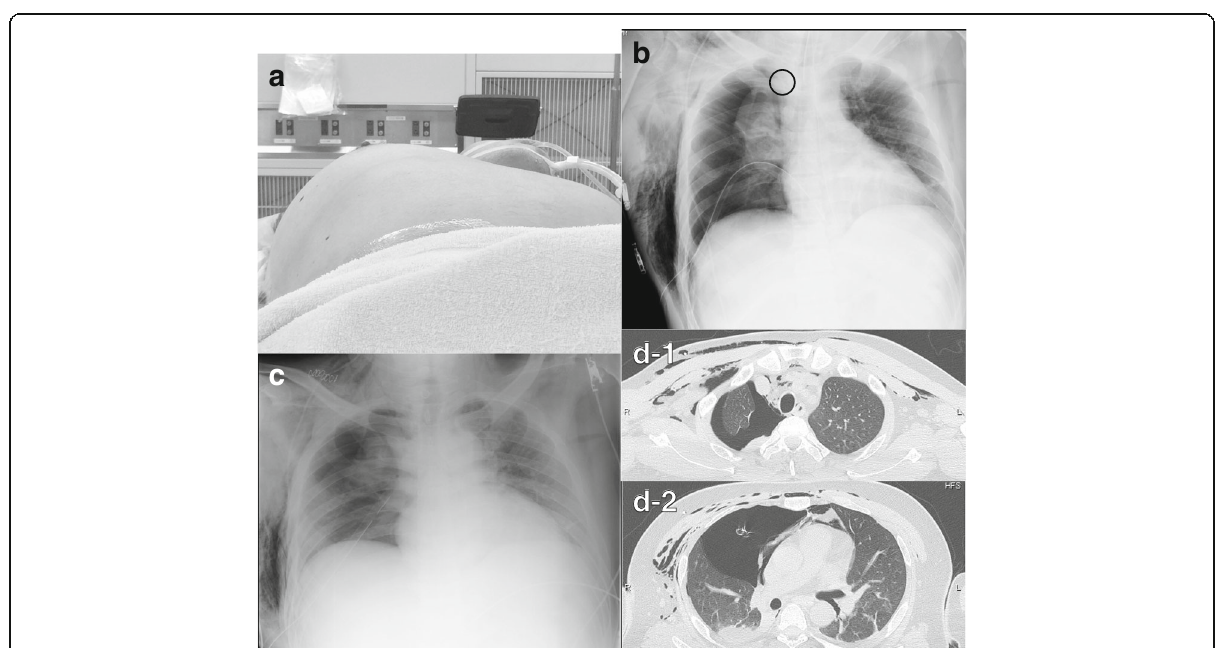
Fig. 1 Postoperative images. a Significant chest distention on the right side. The photograph was taken after needle thoracentesis. b Chest X-ray showing right pneumothorax, heart shifted to the left, massive subcutaneous emphysema, and malpositioned chest drainage tube, which had to be re-positioned. c Correct placement of the drainage tube. d-1 , d-2 Chest CT showing subcutaneous and mediastinal emphysema, right pneumothorax, and no bullae or